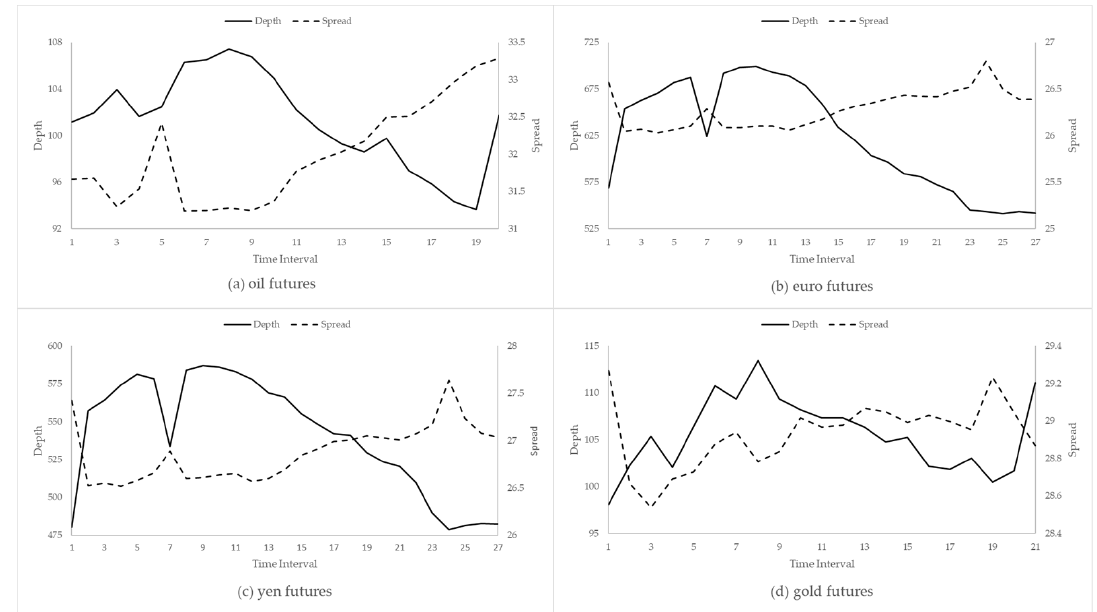
Figure 1. Intraday depth and spread behavior. This figure presents the intraday behavior of the depth and spread over the day using 15-min intervals. ( a ) Depicts oil futures, ( b ) depicts euro futures, ( c ) depicts yen futures, and ( d ) depicts gold futures. Depth is calculated as the sum of the depth available across all five levels. Spread is calculated as the sum of the depth-weighted spreads across all five levels. Table 3. Intraday patterns of spread and depth.